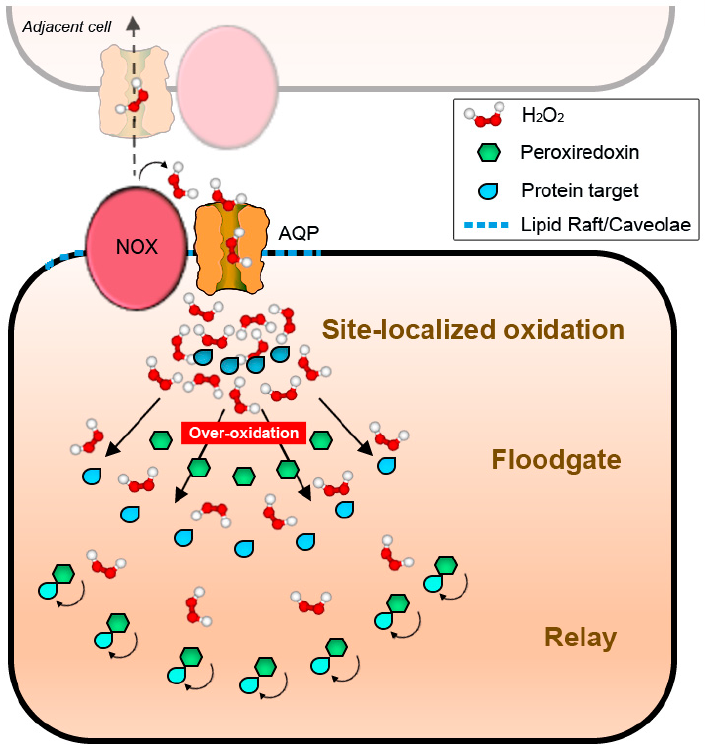
Figure 4. Putative mechanisms adopted by cells to achieve redox signal transmission after peroxiporin-mediated routing of ROS through the plasma membrane. The NOX/AQP system, situated in privileged lipid platforms for signaling (blue dashed line), offers a new perspective to re- interpret the models for redox signal transmission to intracellular targets (depicted as blue teardrops): site-localized oxidation of vicinal proteins will be favored by strategical positioning near the cytosolic mouth of the channel, possibly by localizing them to lipid raft domains, while further proteins would be reached either directly by overoxidation of peroxiredoxins (represented as green hexagons) or indirectly via peroxiredoxin-mediated relays. The particular disposition of NOXes releasing ROS to the extracellular space will also induce similar pathways in a peroxiporin-equipped adjacent cell (upper part of the scheme), thus allowing for a coordinated response. The figure has been organized as a cascade for clarity. However, all modes of signal transduction may be not hierarchical and concur simultaneously. concur